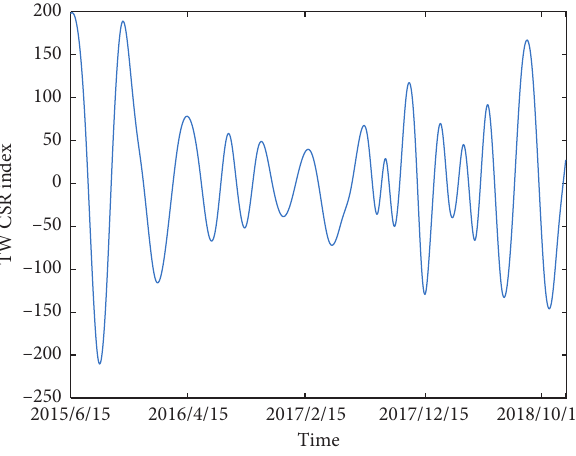
Figure 14: EMD analysis of the Taiwan CSR index used to get IMF4.